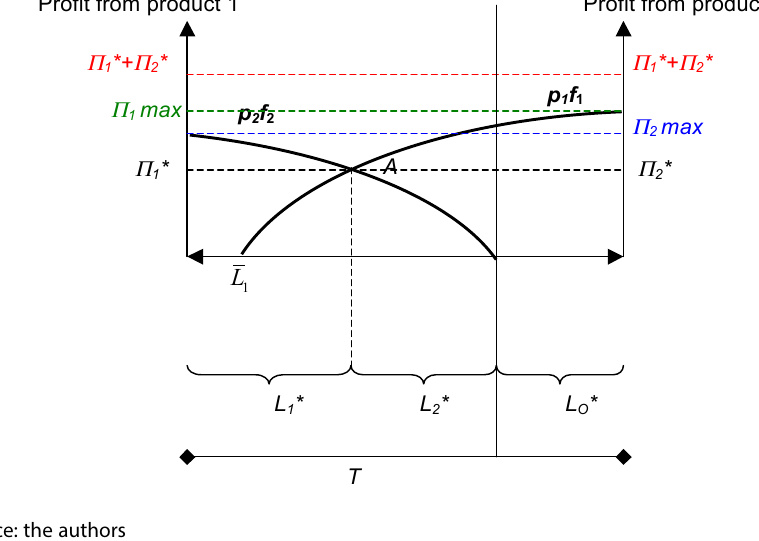
Figure 2. Graphical representation of labour allocation for a part-time farmer allocating little time off farm.